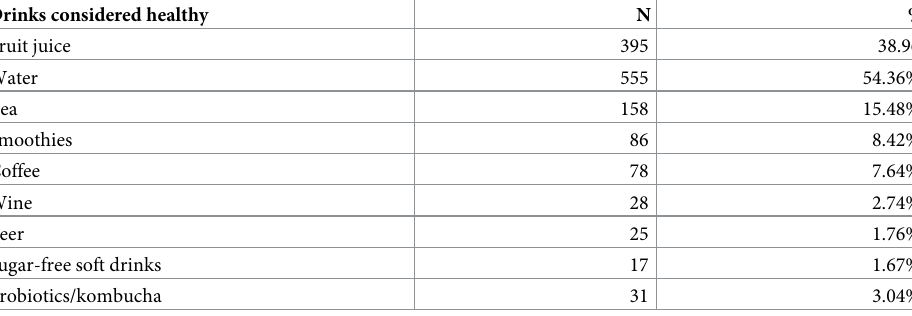
Table 2. Types of drinks consumers consider